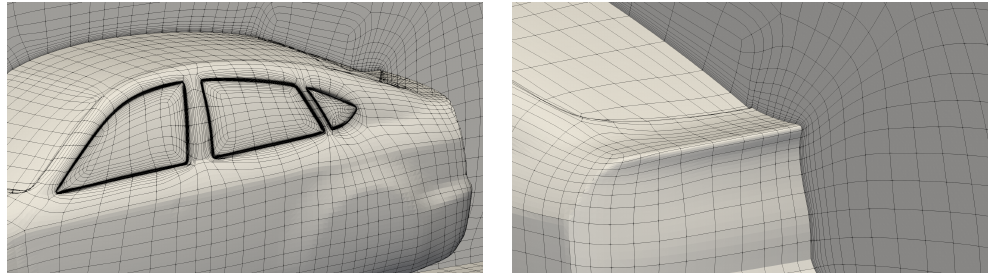
Figure 7. Simplified DrivAer model—Detail of the mesh near the side pillars ( left ) and the rear part of the body ( right ).